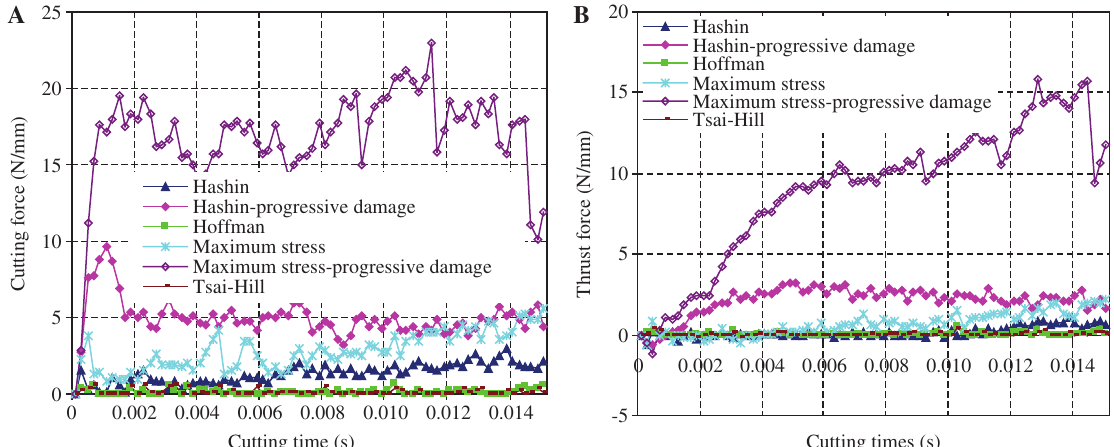
Figure 7: Cutting force and thrust force (fiber orientation 30 ° ).